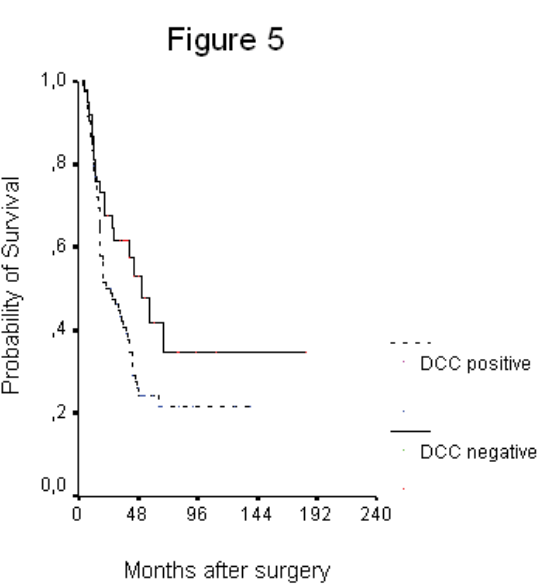
Table 4. Multivariate analysis in relation to overall survival in TS studied